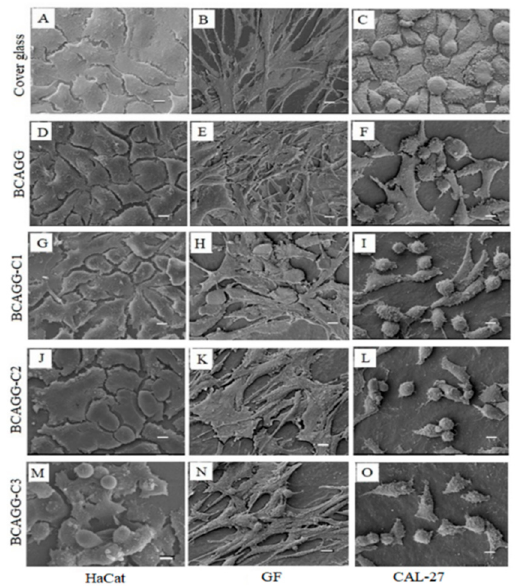
Figure 7. SEM images of HaCaT, GF and CAL-27 on film samples for 48 h (scale bar = 10 µm) .